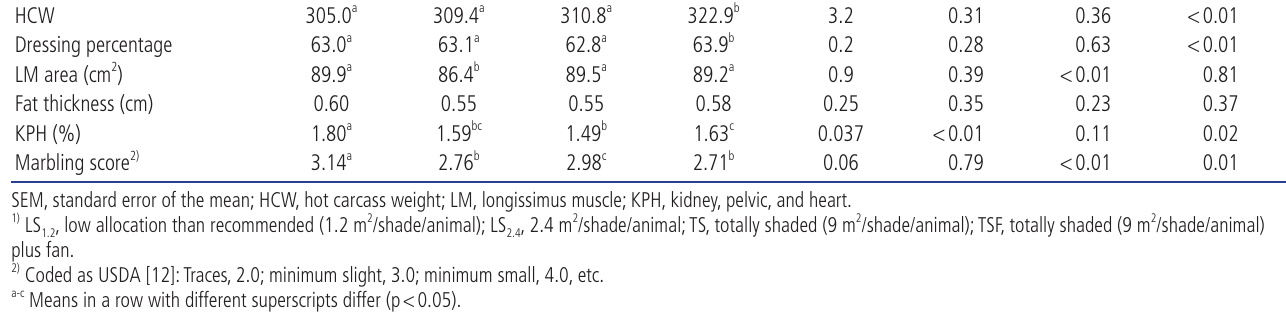
Table 5. Influence of shade treatments on carcass characteristics of feedlot steers